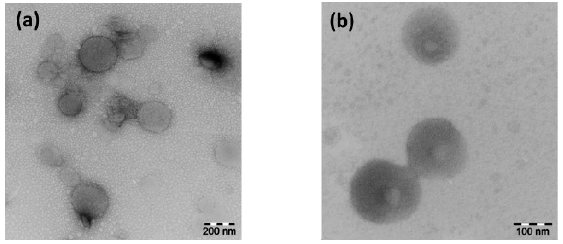
Figure 6. Negative-staining electron micrographs, ( a ) 0.1% dispersion of PXA -g- S15; ( b ) 0.1% dispersion of PDSA -g- S10.